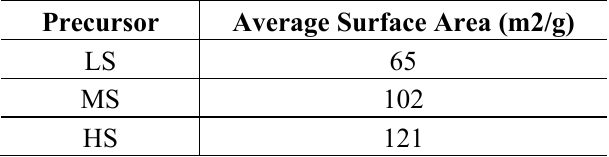
Table 2. BET Surface areas for the products dried after adding the three amounts of